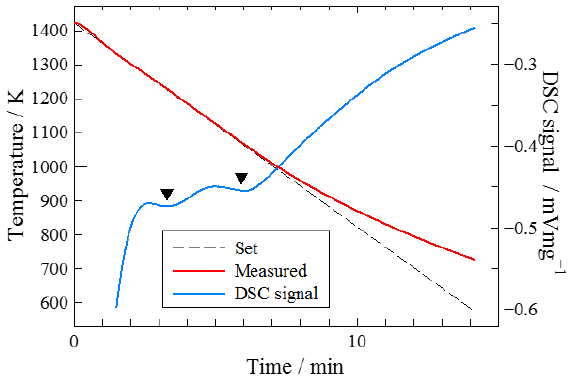
Figure 1. Set and measured temperatures of the D2 alloy together with a typical DSC spectrum; the black downward-pointing triangles indicate exothermal peaks consistent with γ ′ precipitation. The other alloys used in this study exhibited similar results.